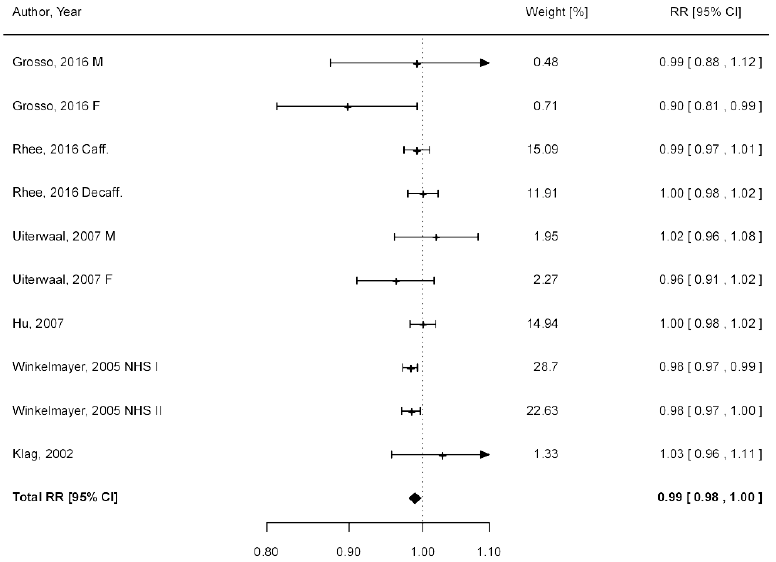
Figure 3. Forest plot illustrating risk of hypertension due to increase intake of one-cup of coffee per day in cohort studies.